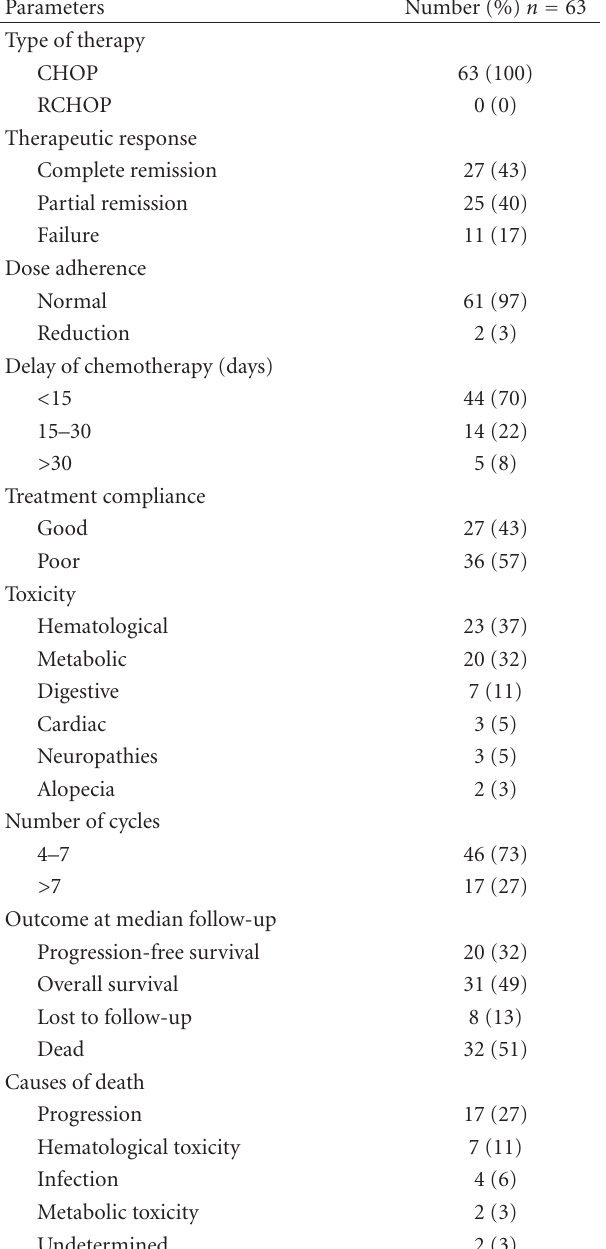
Table 4: Therapeutic and evolutional characteristics of